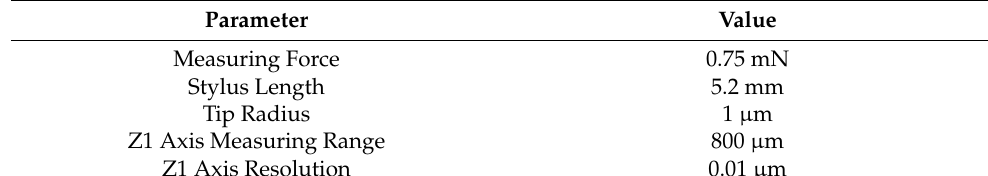
Table 2. Specifications of the roughness detector.